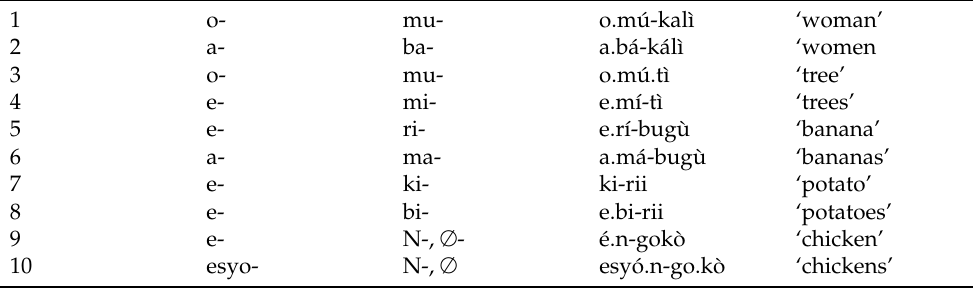
Nouns with bisyllabic stems show reduplication, with the reduplicated noun in the righthand column acquiring the meaning ‘a real X’ with a positive connotation. Table A2. Common nouns in Kinande (Mutaka and Hyman 1990, p. 76).